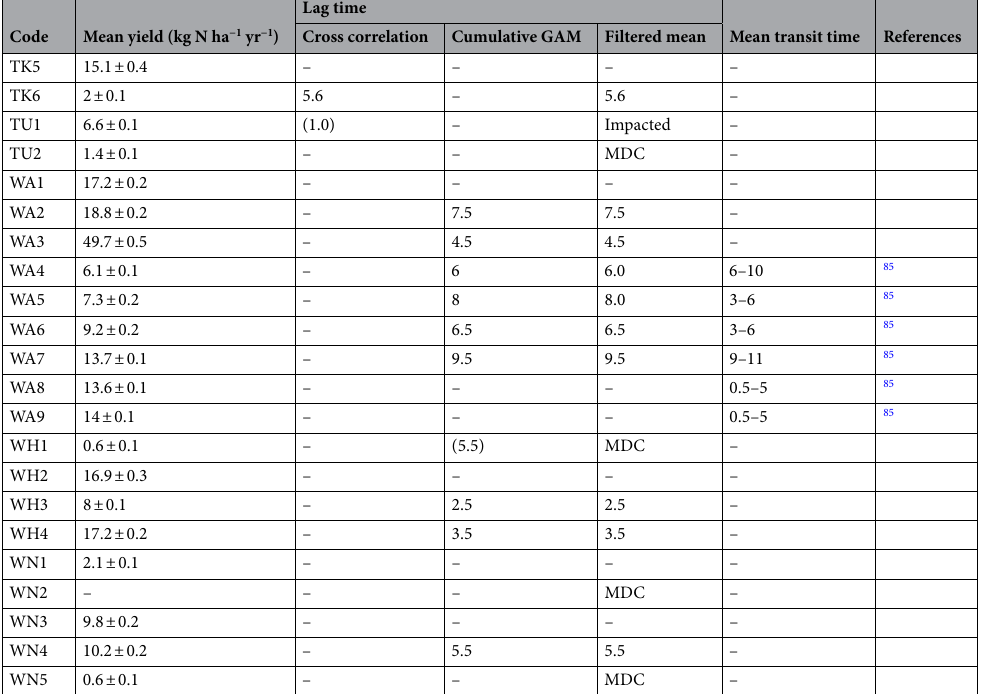
Table 2. Mean yield (± standard error) of nitrate–N and lag times (years) calculated using cross-correlation (using pre-whitened data) and cumulative generalised additive models (GAMs) and the resulting mean lag time after filtering out sites that were either impacted by hydroelectric schemes or were recently disturbed causing uncharacteristically high sediment loads, or under minimally disturbed conditions (MDC), i.e. > 90% native forest, mountains or scrub. The mean hydrological transit time for baseflow is also given for reference. Lag times in parentheses were for sites that were either impacted or under MDC and excluded from further analysis. 1 A lag time either could not be calculated or no data exists.